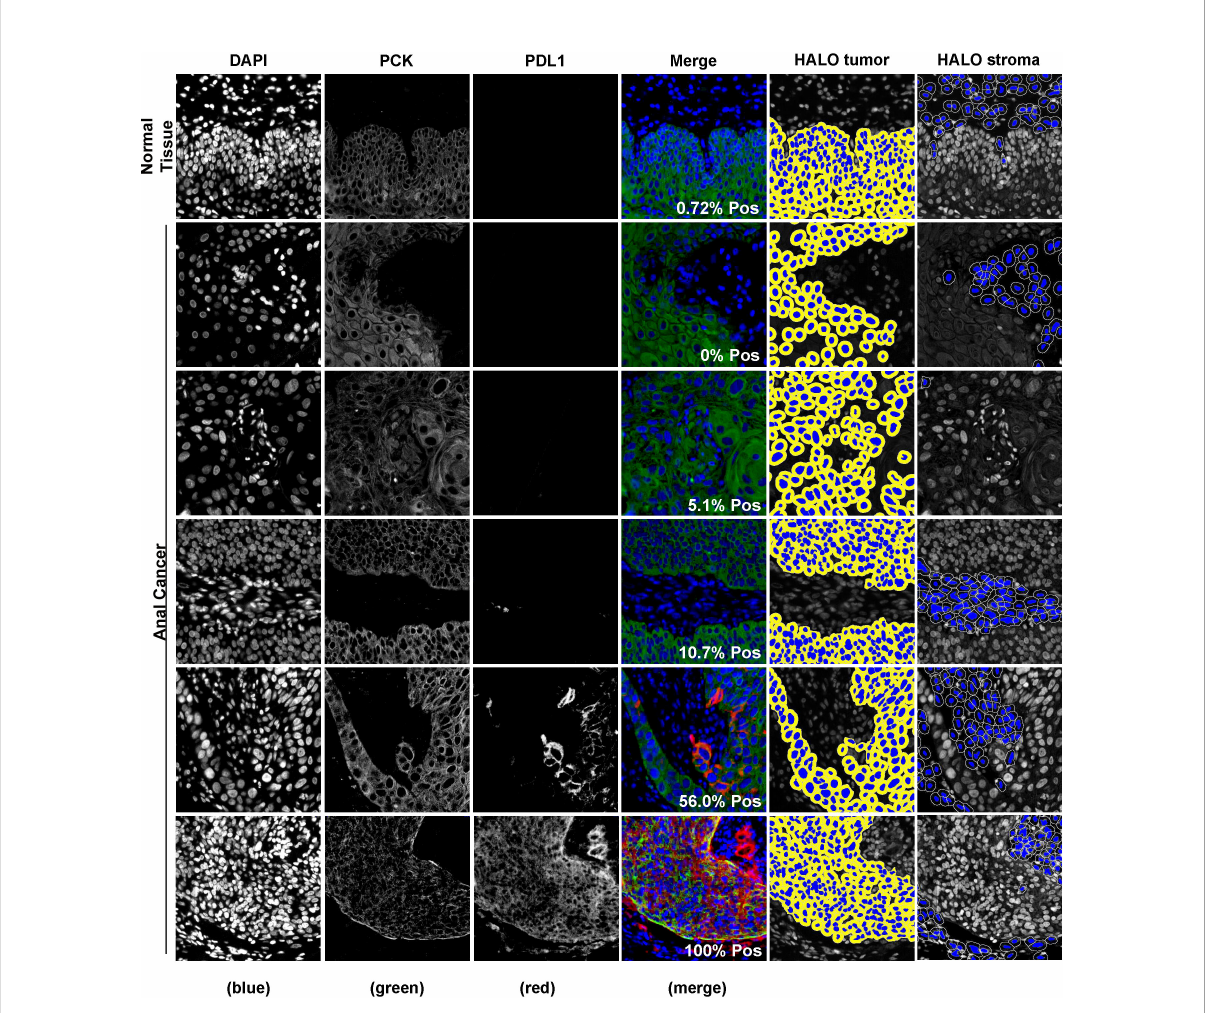
FIGURE 1 Representative images of fl uorescence immunohistochemistry for PD-L1. Samples were visualized using PD-L1 antibody and cytokeratin to identify tumor regions. Digital image analysis using HALO was used to determine the percentage of PD-L1 positivity in the tumor and the tumor inverse mark-up region (HALO tumor and HALO stroma,